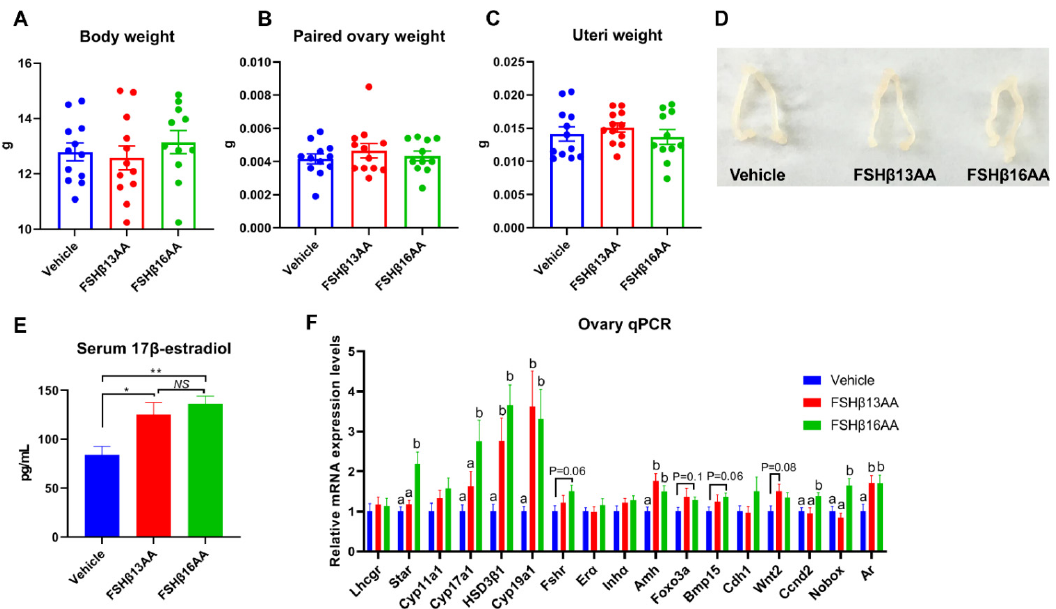
Figure 4. FSH β 13AA/FSH β 16AA on days 25 to 28 in the prepubertal female mice promote ovarian steroidogenesis and the follicle development on day 29. Four consecutive peptide treatments had no significant effects on the body ( A ), paired ovaries ( B ), or uteri ( C ) weights on day 29. ( D ) Representative images of the ovaries and uteri from each group. ( E ) Serum 17 β‐ estradiol concentrations on day 29. * p < 0.05, ** p < 0.01, NS, not significant. ( F ) mRNA expression levels of the ovarian steroidogenesis ‐ and follicle development ‐ associated genes. Lhcgr , luteinizing hormone receptor; Star , Steroidogenic acute regulatory protein; Cyp11a1 , cytochrome P450 family 11 subfamily A member 1; Hsd3 β 1 , 3beta ‐